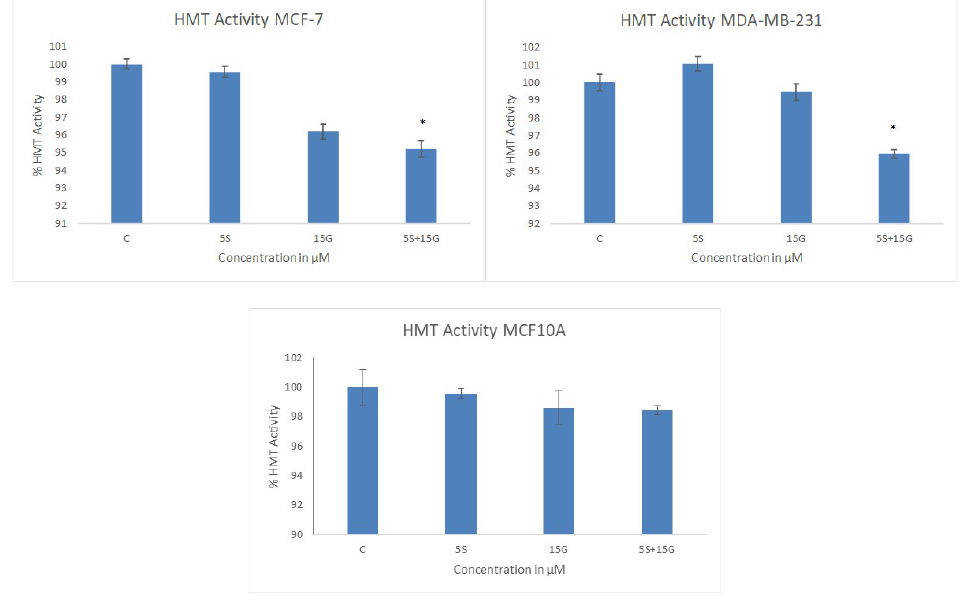
Figure 7. HMT activity. HMT enzymatic activity in breast cancer cells is downregulated by the combinatorial regimen: Combinatorial GEN and SFN downregulates HMT activity in MCF-7 cell lines with the combination being the most effective. GEN and SFN downregulate HMT activity in MDA-MB-231 cells with the combination being the most effective ( n = 3; * p < 0.05). Combinatorial GEN and SFN does not significantly downregulate HMT activity in MCF10A non-cancerous cells. Data are presented as mean ± SD.